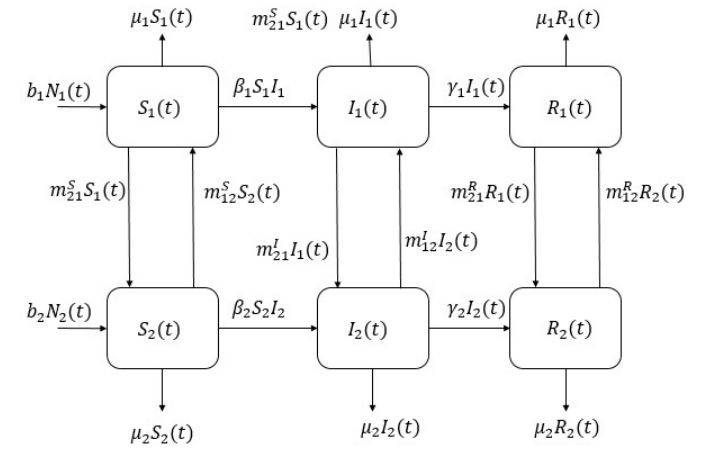
Fig. 3 Transfer diagram for an SIR metapopulation compartmental model (see